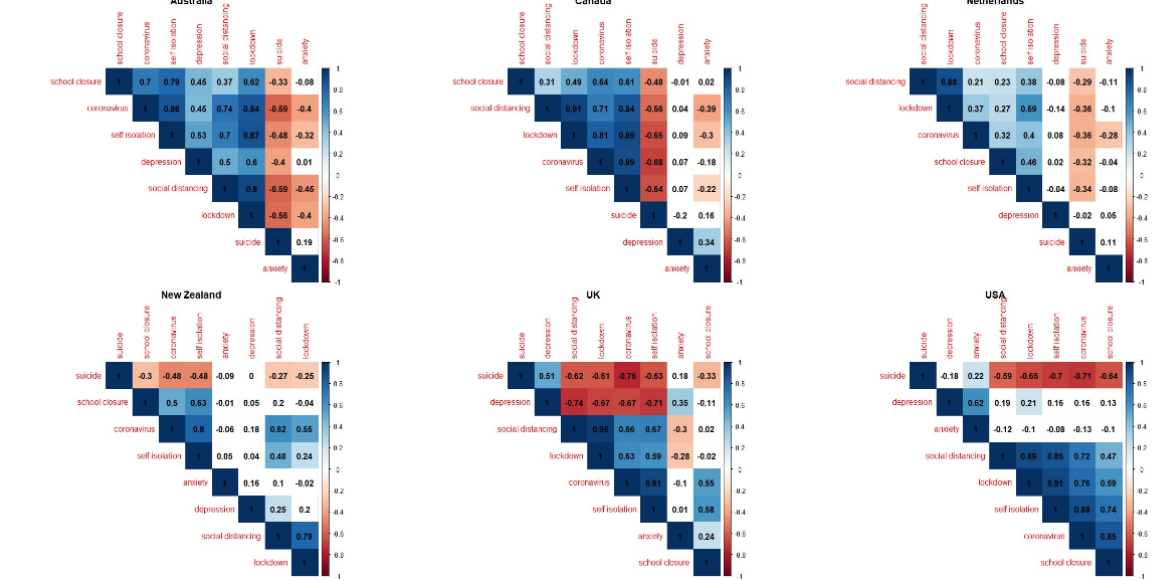
Figure 2. Correlation matrices that represent the pairwise Pearson correlation coefficients of Google Trends search queries for 6 selected countries.